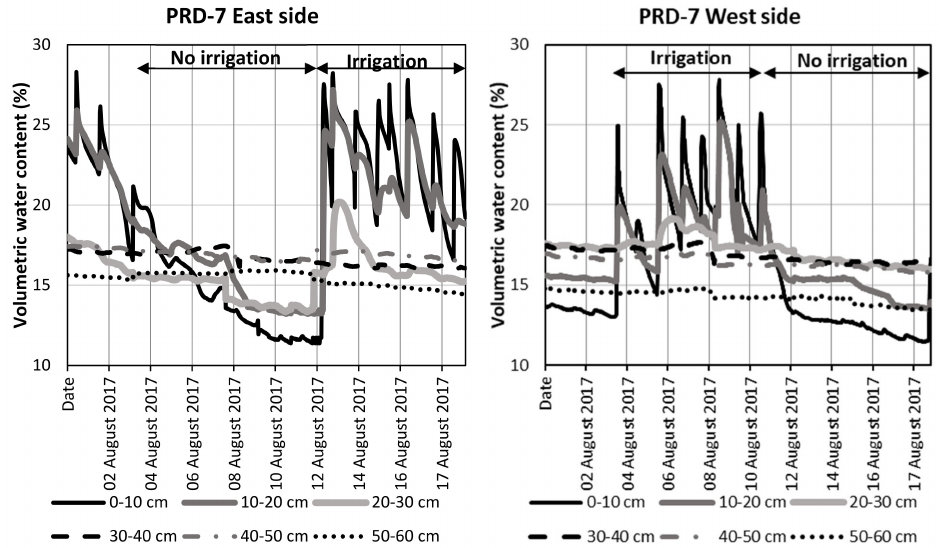
Figure 5. Pattern of soil volumetric water content for ‘Orogrande’ clementine during one representative PRD-7 irrigation / no-irrigation cycle in August 2017. Capacitance probes were placed in the east side and the west side of the same tree and measurements were recorded every 15 min. Arrows indicate the alternation between periods of irrigation and periods of